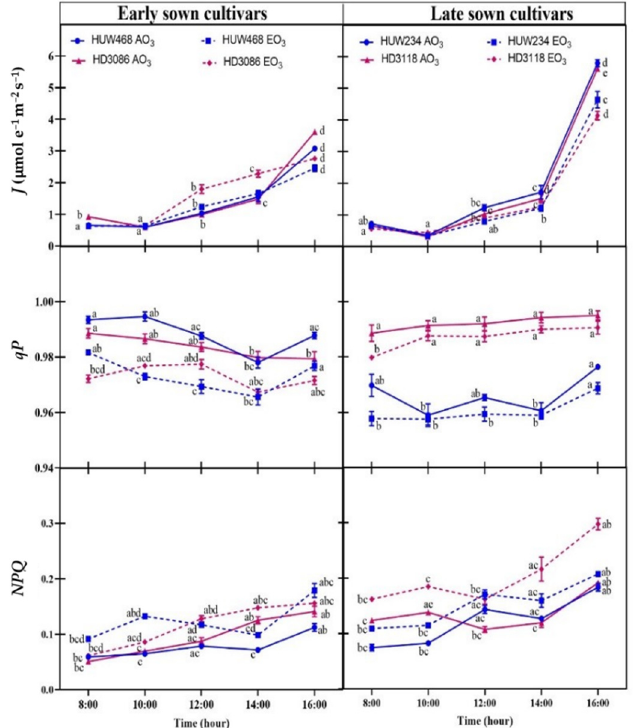
Figure 3. Diurnal variations in chloroplastic electron transport rate ( J ), photochemical quenching ( qP ), and non-photochemical quenching ( NPQ ) of flag leaves in early (HUW468 and HD3118) and late sown (HUW234 and HD3118) wheat cultivars under ambient and elevated O 3 treatments. The letters on top of the line graph are based on the Tukey test among the 5 different time intervals of a day. Lines without the same letter are significantly different from each other at p < 0.05. Values are mean ± SE; N = 5 replicate leaves of 5 plants for each treatment. Solid lines represent plant response under ambient O 3 condition and dotted lines indicate plant response under elevated O 3 condition. Different color in a box represents different cultivar.